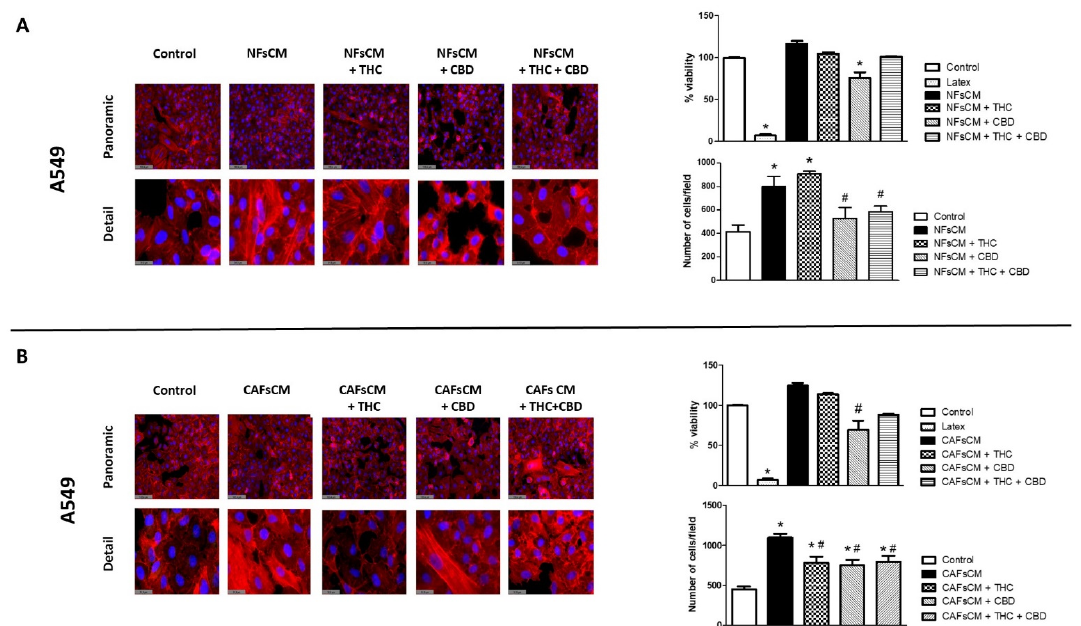
Figure 3. Effect of cannabinoid agonists on A549 cell morphology, viability, and cell density changes induced by stromal-cell-conditioned medium. Culture medium was conditioned with NFs (NFsCM) or CAFs (CAFsCM) treated or not with 30 µM THC, 30 µM CBD, or an equimolar mixture of 10 µM THC + CBD. A549 cells were cultured with NFsCM ( A ) or CAFsCM ( B ) for 72 h. Cellular morphology was studied by the fluorescent staining of F-actin microfilaments, using rhodamine-conjugated phalloidin. Representative fluorescence images corresponding to 3 different experiments are shown. The percentage of viability was measured by the MTS assay using latex as a positive control for cytotoxicity. Cell density was obtained by counting the number of DAPI-stained cell nuclei in five fields. The mean ± SD of 3 different experiments is represented. A triplicate was analyzed in each of the experiments. * p < 0.05 compared to the control group (white bars). # p < 0.05 compared to the NFsCM or CAFsCM in the absence of cannabinoid agonists (black bars). Scale bar is equal to 100.4 (panoramic images) or 31.5 (detail images) µm.